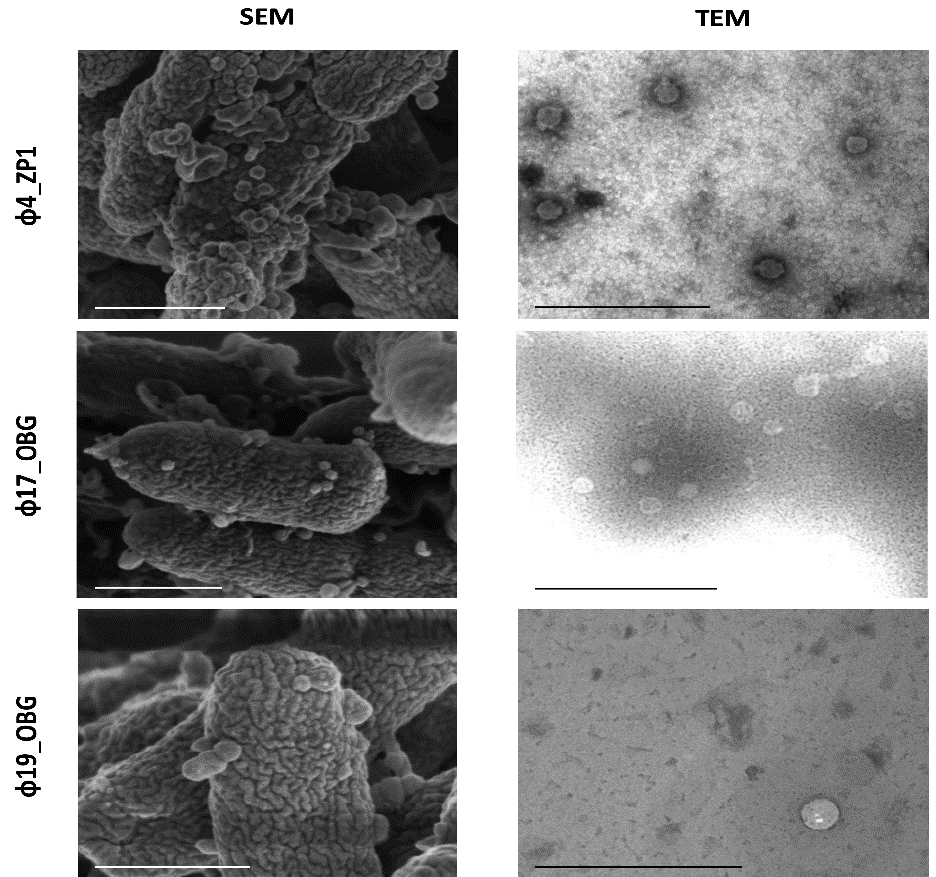
Figure 1. Scanning electron microscopy (SEM) and transmission electron microscopy (TEM) phage